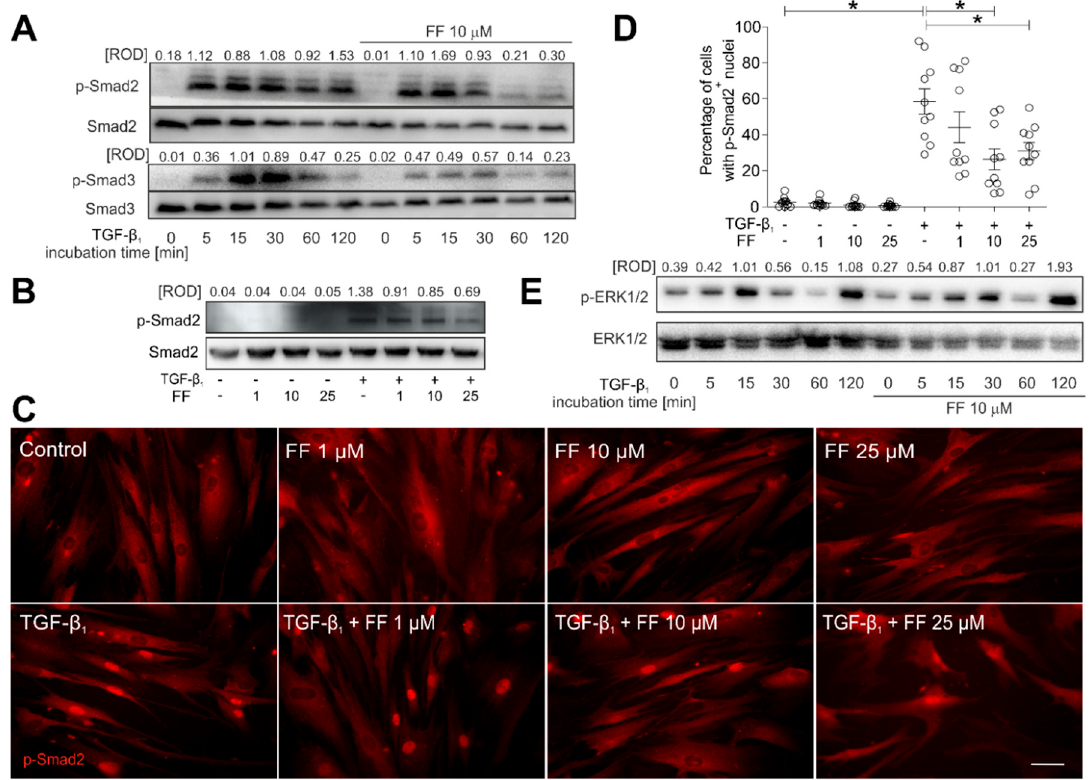
Figure 4. Fenofibrate affects TGF- β 1 -dependent Smad signaling pathway activity in HBFs. ( A ) Cells cultivated in DMEM supplemented with TGF- β 1 (5 ng/ml) in the absence or presence of FF (10 μ M) for different time points (0–120 minutes). Then, the cells were lysed, and the total cell lysates were analyzed using immunoblotting. Smad2, Smad3, and their phosphorylated forms were detected using primary antibodies against Smad2, Smad3, phosphorylated (p)-Smad2(Ser465/467) and p-Smad3(Ser423/425), respectively (see Materials and methods; Section 4.7). Representative membranes are shown. Densitometric quantification is presented as values of relative optical densities (ROD) ( n = 5) of phospho-Smads in relation to Smads (as control proteins). ( B ) Immunoblots with relative optical density (ROD) of p-Smad2(Ser467) in relation to Smad2 are presented in HBFs treated by TGF- β 1 (5 ng/mL) in the absence or presence of FF (1–25 µ M) for 1 h. The results represent mean ± SEM of five independent experiments. ( C , D ) HBFs ( n = 10) cultured in the conditions described in ( B ) were fixed with 3.7% formaldehyde/PBS, permeabilized, and immunostained for p-Smad2. The fractions of cells with pSmad2 + nuclei were determined using fluorescence microscopy. Representative photos were selected. Scale bar = 25 µ m. Data represent the mean ± SEM of ten independent experiments in triplicate. ( E ) HBFs cultured in the conditions described in ( A ) were lysed and analyzed by Western blot. Representative immunoblots with relative optical density of p-ERK1/2 in relation to ERK1/2 are presented. Statistical significances were tested using one-way ANOVA with the Bonferroni multiple comparison post hoc Test; * p ≤ 0.05. Note that fenofibrate efficiently attenuates the TGF- β 1 -induced Smad signaling, but not the ERK-dependent